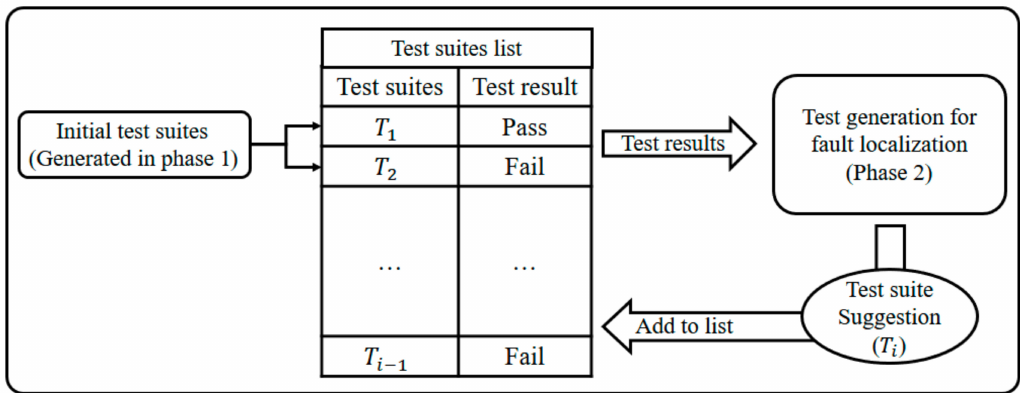
Figure 5. Test-suite generation process in Phase